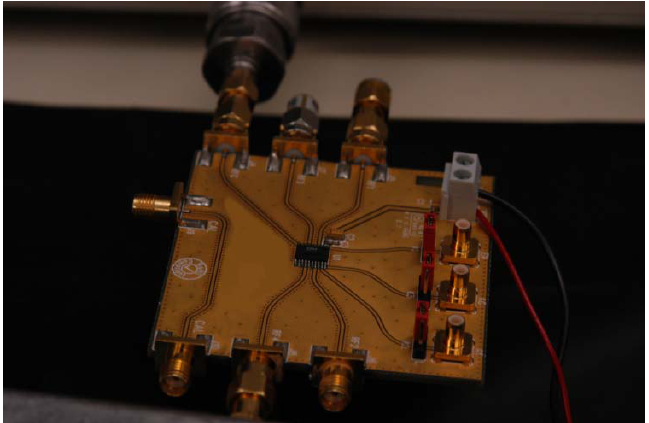
Figure 6. The experimental prototype of a low cost electronic calibration circuit. The circuit consists of insertion of a single-pole-4-throw 2.5 GHz bandwidth CMOS semiconductor switch which is inserted between the coaxial interconnecting cable and the sensing probe, per the schematic diagram as detailed in Figure